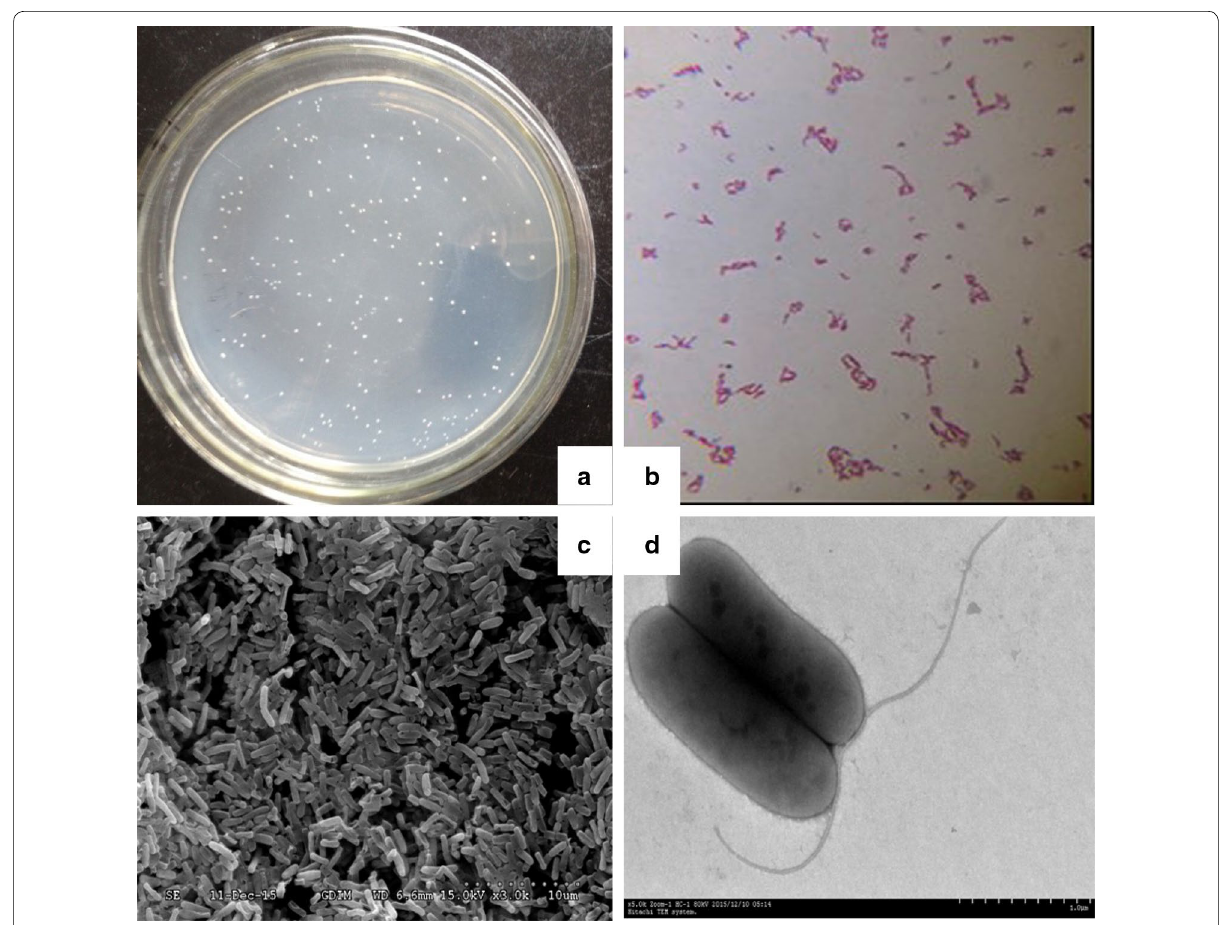
Fig. 3 Morphological characteristics of strain Gan‑35. a Colonies of strain Gan‑35 on the LB agar plate; b a photograph of Gram staining (20 c a photograph of scanning electron microscopy (